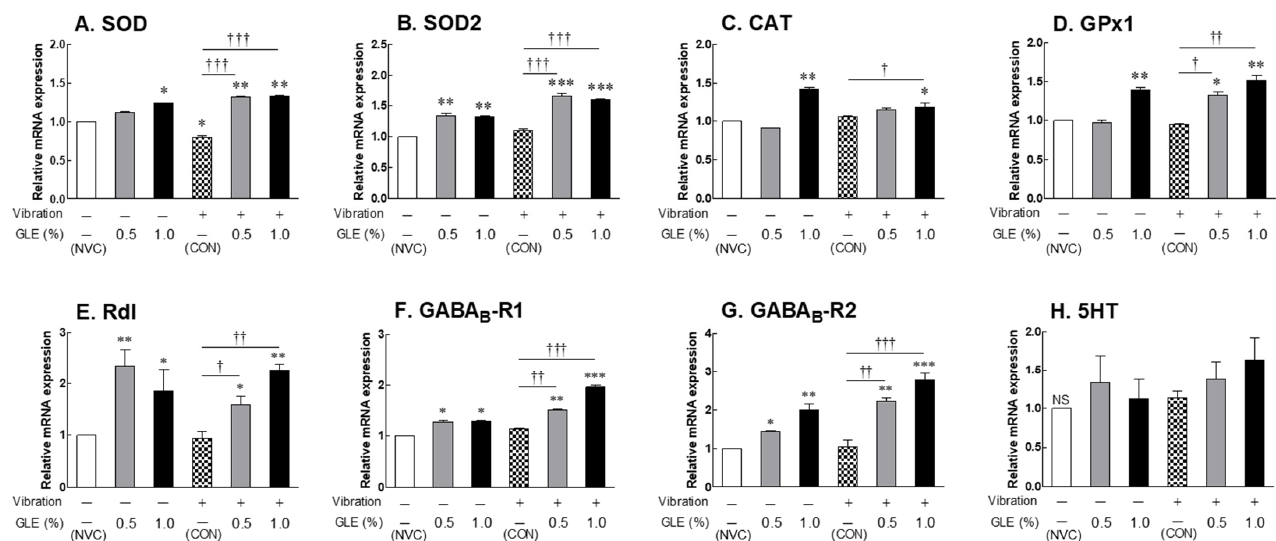
Figure 2. Effects of GLE (green lettuce leaf extract) on ( A ) SOD, ( B ) SOD2, ( C ) CAT, ( D ) GstD1, ( E ) Rdl, ( F ) GABAB-R1, ( G ) GABAB-R2, and ( H ) 5HT mRNA expression by vibration stress in fruit flies. Fly heads were collected after 12 h/12 h cycles for two weeks. Experimental groups include the no-vibration-stress control group (NVC), control group (CON, stress-induced vibration), and GLE (green lettuce leaf extract)-treated groups with or without stress (0.5 and 1.0%). Values are presented as the mean ± standard error of the mean (SEM) for each group, n = 150. * p < 0.05, ** p < 0.01, and *** p < 0.001 when compared with the NVC group. † p < 0.05, †† p < 0.01, and ††† p < 0.001 when compared with the CON group (ANOVA followed by post-hoc Tukey’s test). NS, not significant.